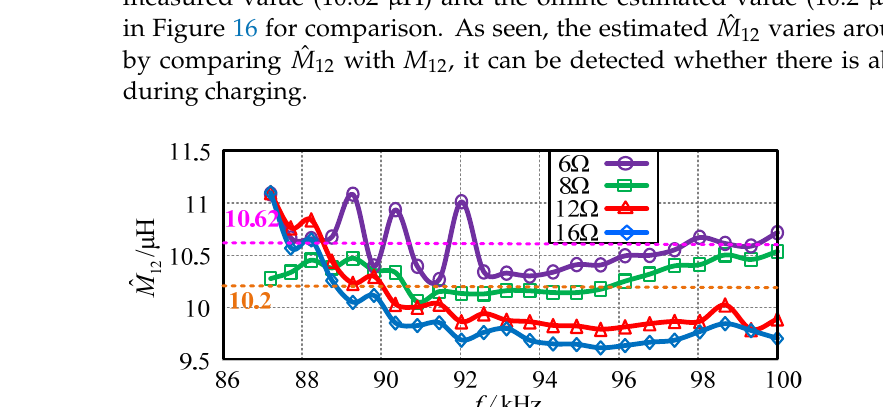
Figure 17. Identification results of the load resistance, R L . 5.4. Closed-Loop Control Results Based on the dynamically estimated values of V o and I o , constant current (CC) and constant voltage (CV) charging for S/S compensation are also achieved by employing only a transmitter controller. Here, the variable frequency control is employed. The operating